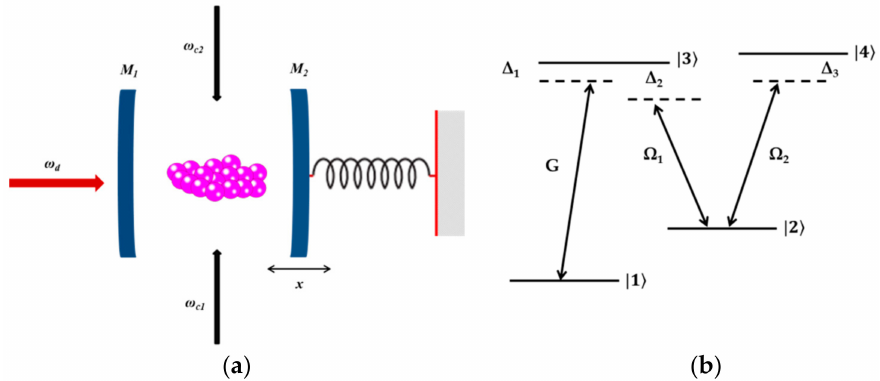
Figure 1. ( a ) Schematic of cavity optomechanical system containing an atomic ensemble. ( b ) Structures of N -type atomic